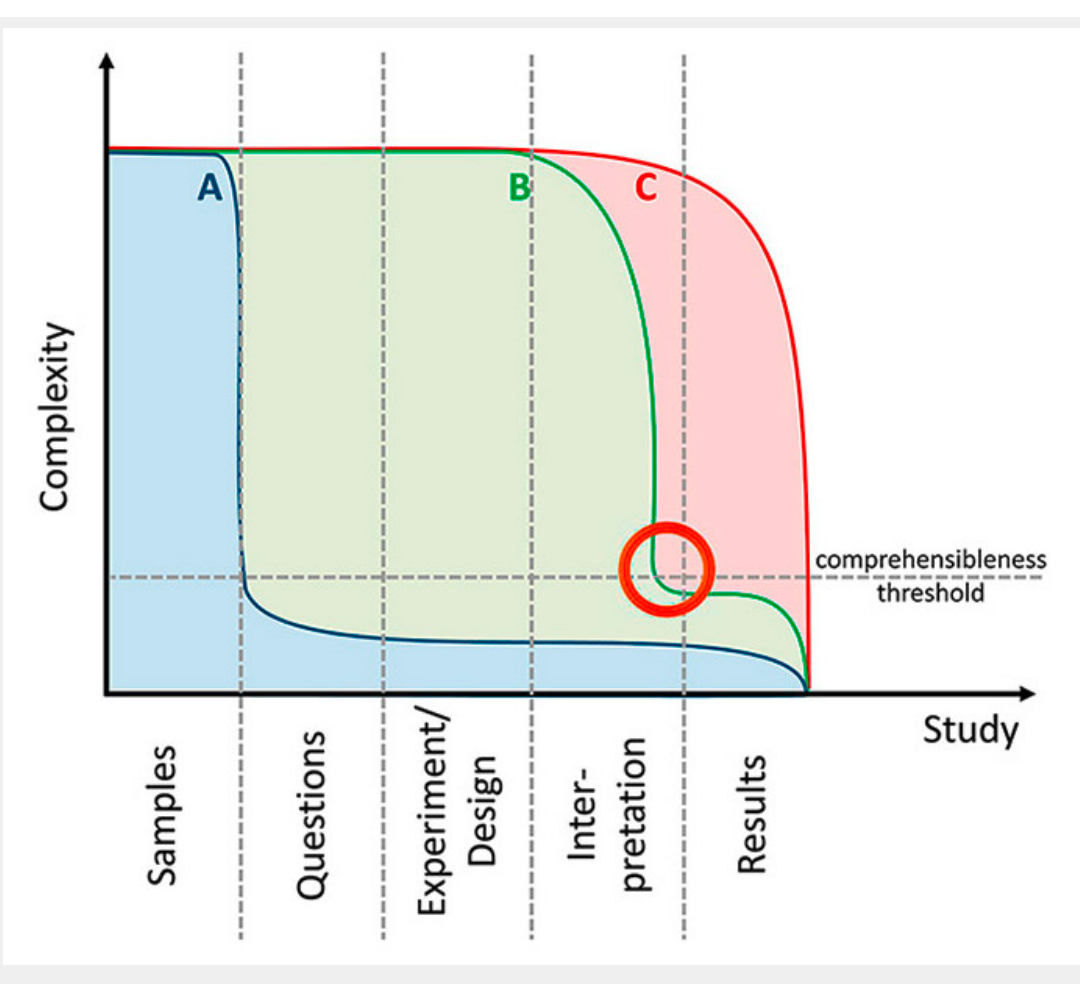
Figure 3 Complexity of the conventional “hypothesis-driven” approach (A) compared with “hypothesis-free” study approaches (B & C). Most of the published metabolomics studies resemble study type C: differences are determined and principal component analysis (PCA) score plots are frequently drawn. But since complexity is not really reduced, interpreting the data and answering the study questions is difficult and sometimes impossible. Study type B includes a complexity reduction step (e.g. variable/model selection, see orange circle) and thereby facilitates interpretation. Elaborate statistics are necessary to perform this reduction, but they are unavoidable since the complexity of the information contained in the “-omics” data usually exceeds human comprehension (the “comprehensibleness threshold” signifies this